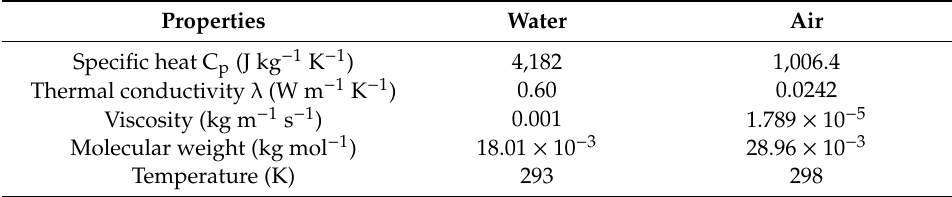
Table 3. Water and air properties considered in the numerical